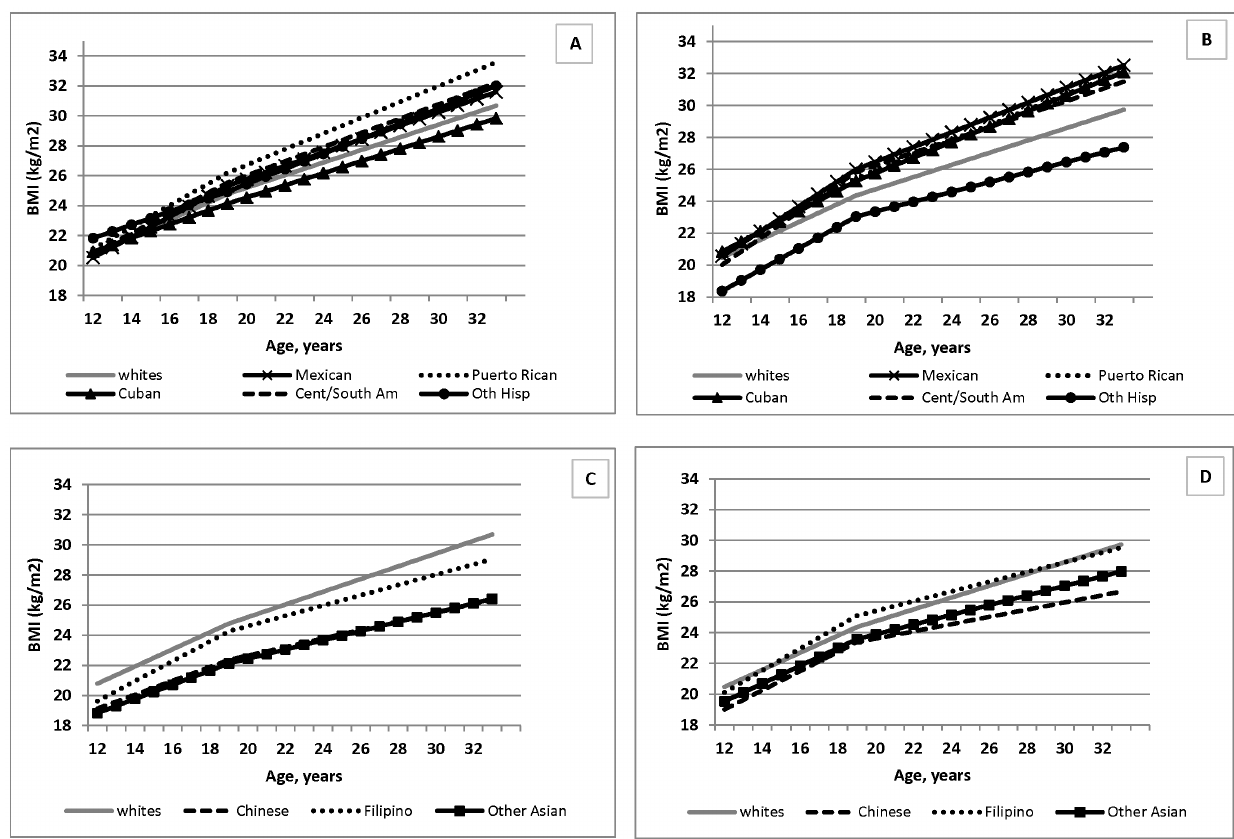
Figure 2. Adjusted BMI trajectories by Hispanic and Asian subgroups compared to whites, females and males, National Longitudinal Study of Adolescent Health. A) Hispanic subgroups vs. whites - Females, B) Hispanic subgroups vs. whites - Males, C) Asian subgroups vs. whites – Females, D) Asian subgroups vs. whites - Males. BMI=body mass index. Predicted BMIs are based on adjusted model from Model 4, Table 2, stratified by sex.